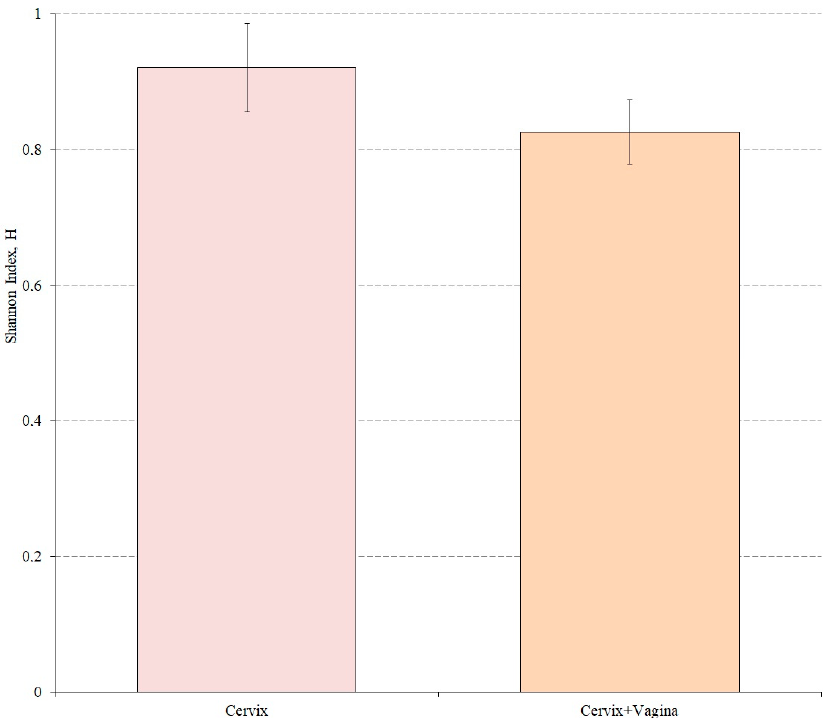
Figure 3. Shannon index as an indicator of alpha diversity for the studied groups ( p = 0.0181). According to the results of the analysis, the Shannon index for the cervical canal group was 0.9216, while for the cervical canal and vagina group this indicator was 0.8268. The alpha microbiome diversity of the cervical microbiome was statistically significantly higher than in the group where cervical and vaginal samples were mixed ( p = 0.0181). Differences in microbiome composition between the two study groups were assessed for all detected bacterial species. Thus, according to the data obtained, statistically–significant differences were observed for the species Muribaculum intestinale ( p = 0.0029) , Aquabacterium parvum ( p = 0.0156) and Methyloversatilis universalis ( p = 0.0156), which prevailed in the samples taken only from the cervical canal, while Psychrobacillus psychrodurans ( p = 0.0154) prevailed in the group where the samples were taken from the cervical canal and vagina. In total, we found 32 very strong correlations (R ≥ |0.8| and p ≤ 0.05) between bacteria in the cervical canal and 22—in cervicovaginal samples (Figures 4 and 5). In the text, we describe only Spearman’s correlations with R ≥ |0.9| and p ≤ 0.05.